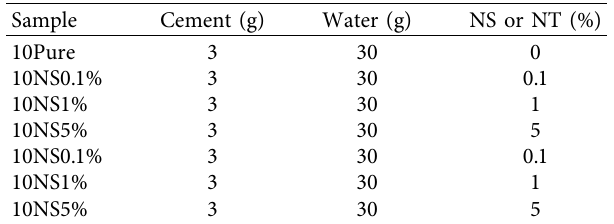
Figure 7: Schematic diagram of the basic principle of convolutional neural network. Table 1: Mix design of water-cement ratio.